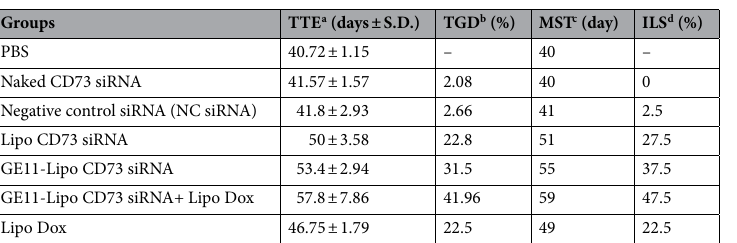
Table 3. Therapeutic efficiency of different liposomal formulations in 4T1 tumor mice model (n = 5). a Time to reach end-point. b Tumor growth delay. c Median survival time. d Increase in life span.